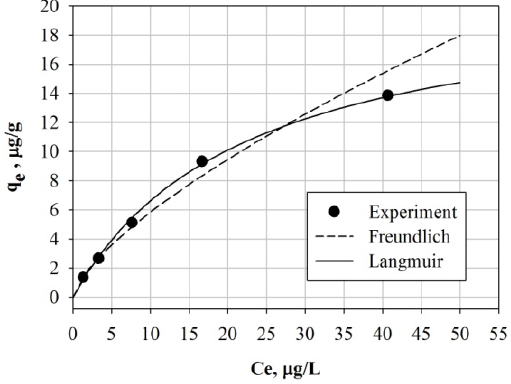
Figure 4. The adsorption isotherm of As(III) onto FeOOH coated sand.